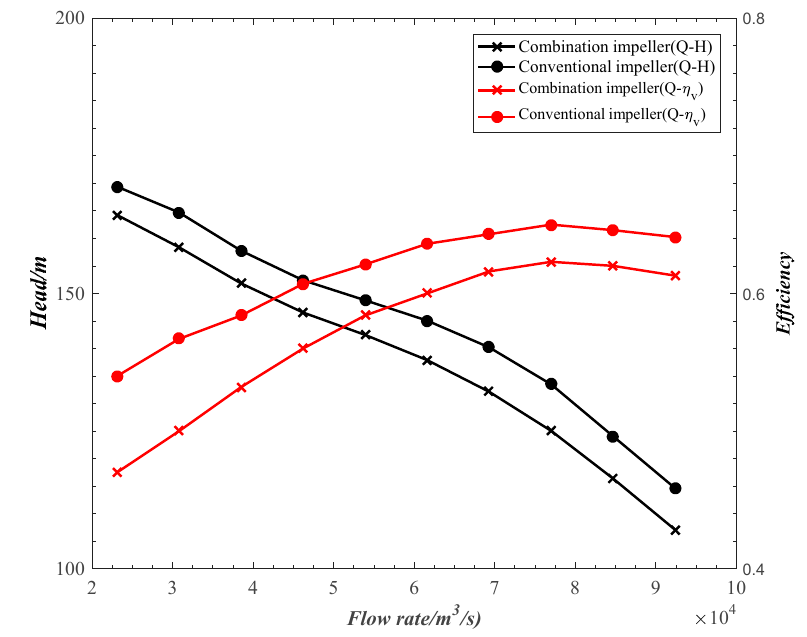
Figure 12. Comparisons of the performance curves.